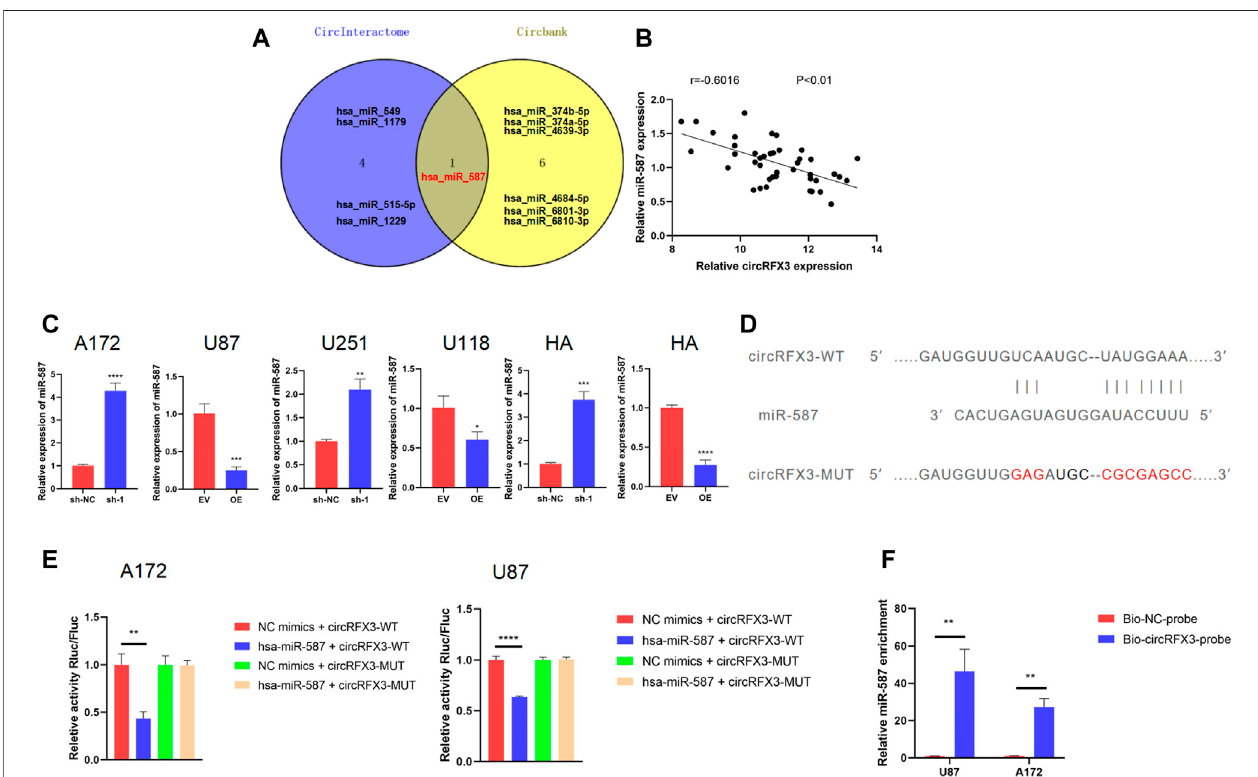
FIGURE 4 | circRFX3 could sponge miR-587 in glioblastoma (GBM) cells. (A) Venn diagram showing that hsa_miR_587 was the only intersection of the two databases. (B) circRFX3 expression was inversely associated with miR-587 in clinical GBM samples. (C) miR-587 was signi fi cantly upregulated after circRFX3 knockdown in A172 and U251 cells and human astrocytes (HAs), whereas miR-587 was downregulated due to circRFX3 overexpression in U87 and U118 cells and HAs. (D) The wild-type (WT) and mutated-type binding sites for miR-587 in circRFX3. (E) The results of the dual-luciferase reporter gene assays showed that the relative luciferase activity of the cells containing the WT miR-587 binding sites in circRFX3 could be obviously inhibited by transfecting miR-587 mimics. The relative luciferaseactivityofthecellsthatcontainedthemutatedbindingsitedidnotchange. (F) AftertheRNApull-downassays,theqRT-PCRresultsshowedthatendogenous miR-587 was a signi fi cantly enriched circRFX3 probe. Statistical analysis was conducted with Student ’ s t -test. * p < 0.05.